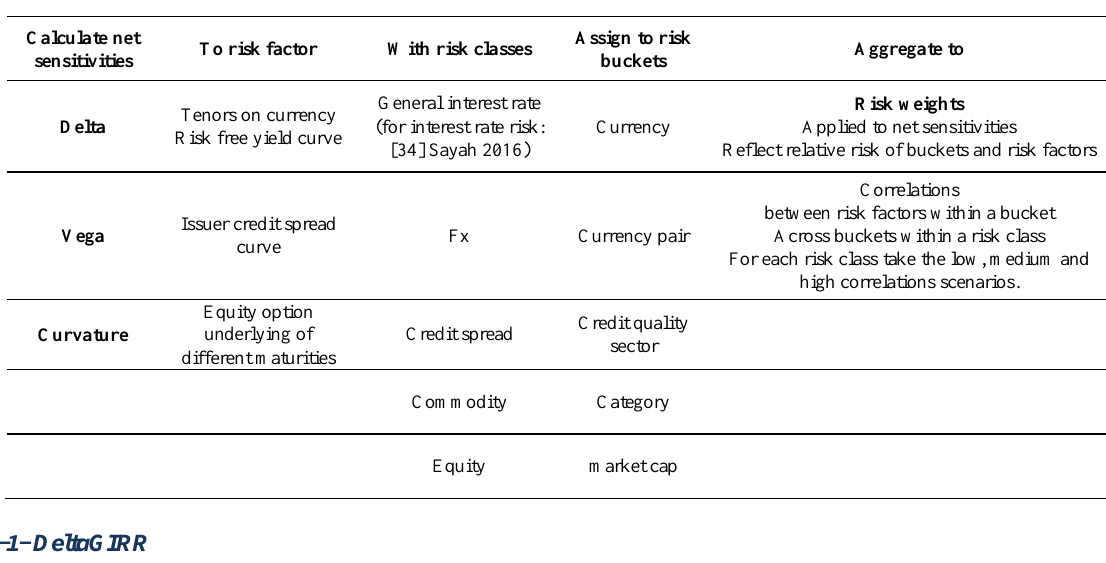
Table 4. The dimensions of the risk